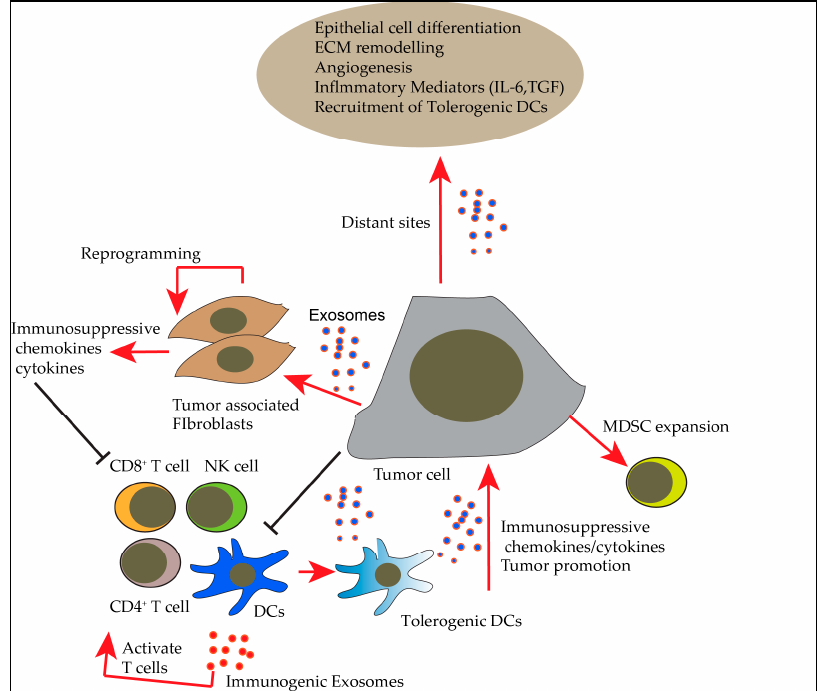
Figure 3. Summary of effects of exosomes on different immune cells and ways by which they promote tumor development and metastasis. tumor development and